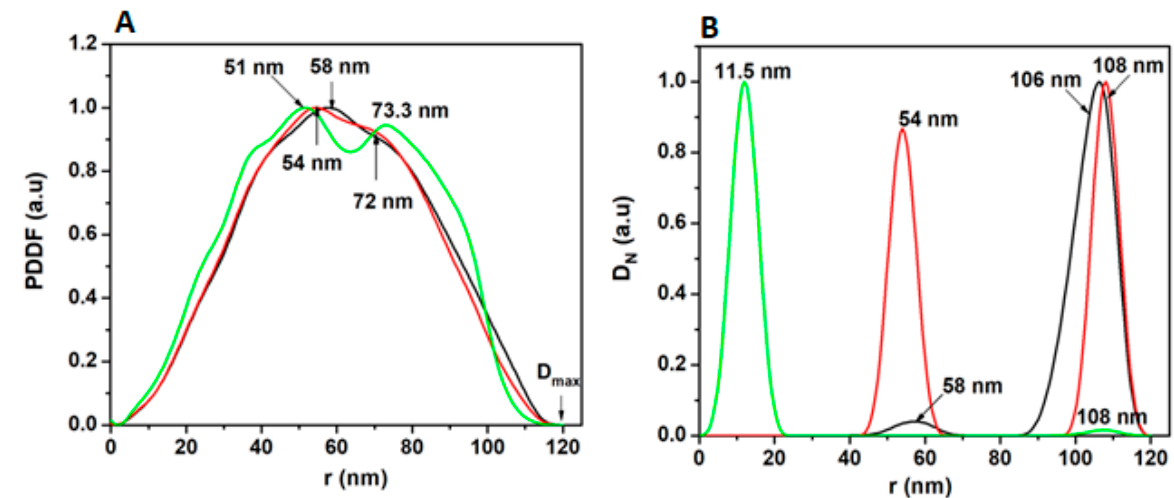
Figure 8. Small-angle X-ray scattering (SAXS) spectra of (PDMA–PVS–Ag 0 ) composite materials. ( A ) Pair-distance distribution function (PDDF) for PDMA (black line), PDMA–PVS (red line) and PDMA–PVS–Ag 0 (green line). ( B ) Number- weighted size distribution function for PDMA (black line), PDMA–PVS (red line) and PDMA–PVS–Ag 0 (green line).